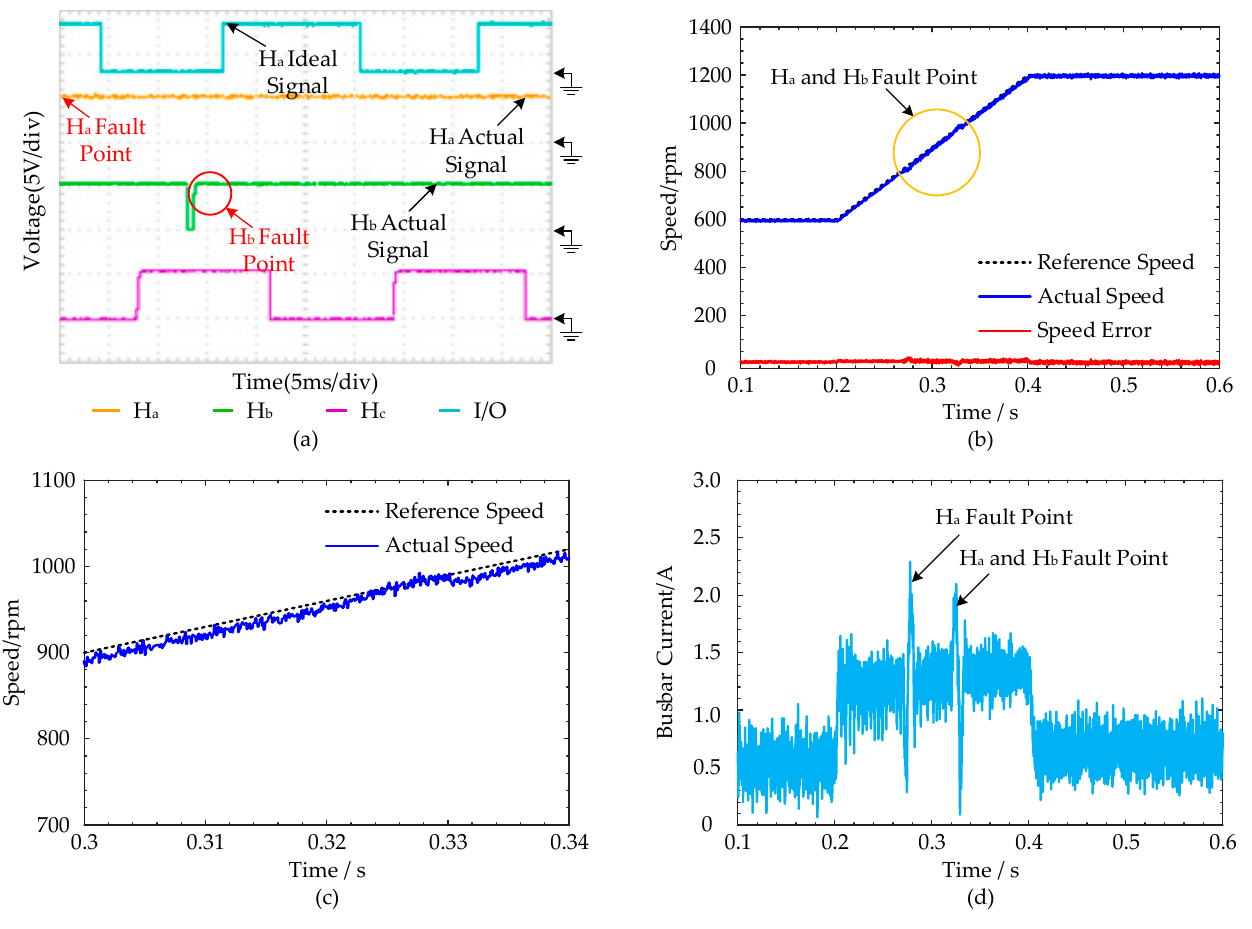
Figure 17. Double Hall fault-tolerant control experimental results: ( a ) the Hall signal curves of the motor; ( b ) the speed curves of the motor; ( c ) the detail speed curves at the fault point; ( d ) the busbar current of the motor.